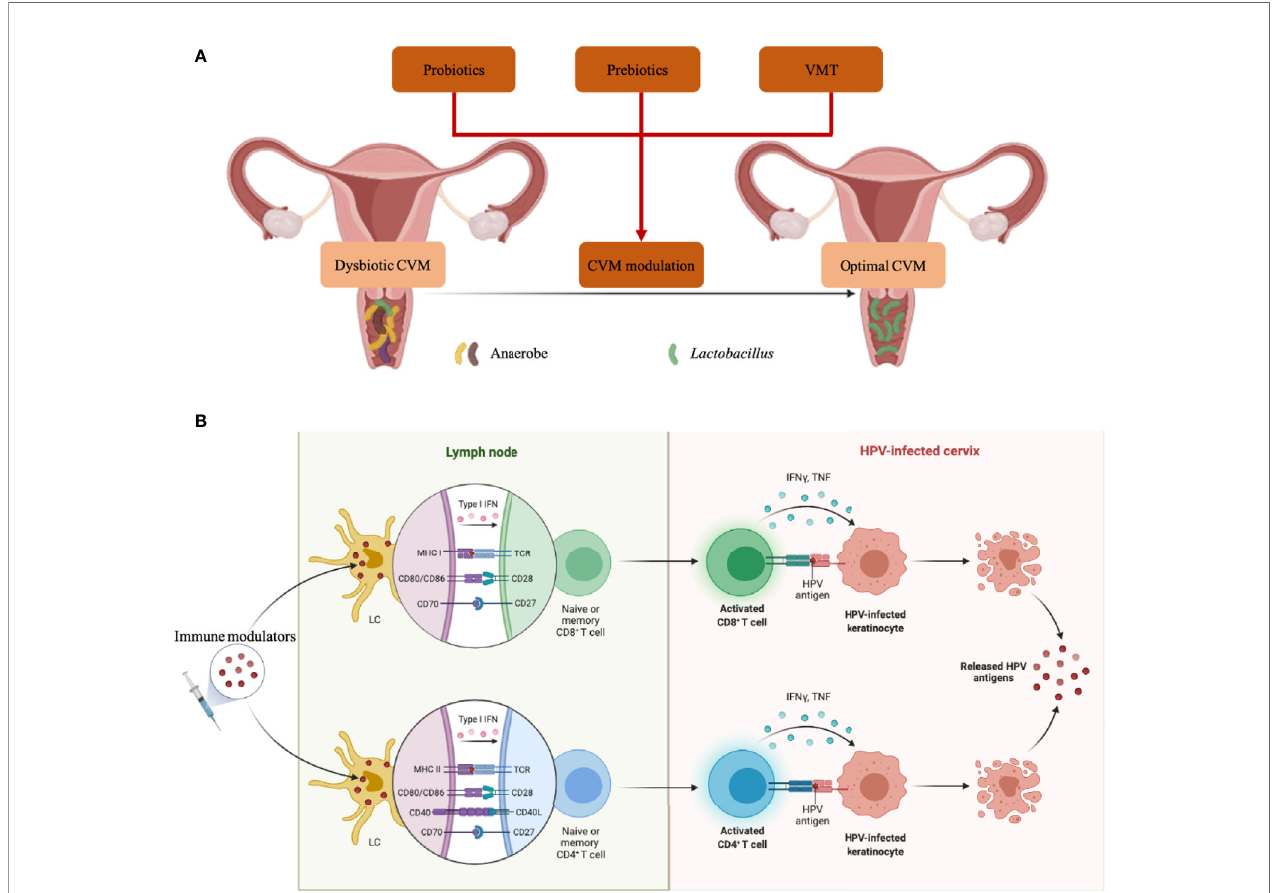
FIGURE 3 | CVM-modulated and -derived products in eliminating HPV infection. (A) Strategies to modulate dysbiotic CVM were characterized by anaerobe overgrowth. (B) Molecules produced by speci fi c microbial strains in CVM can activate LCs in the cervical epithelium, then promote T cell priming and eliminate HPV- infected cells. Icons in BioRender.com were utilized to prepare this fi